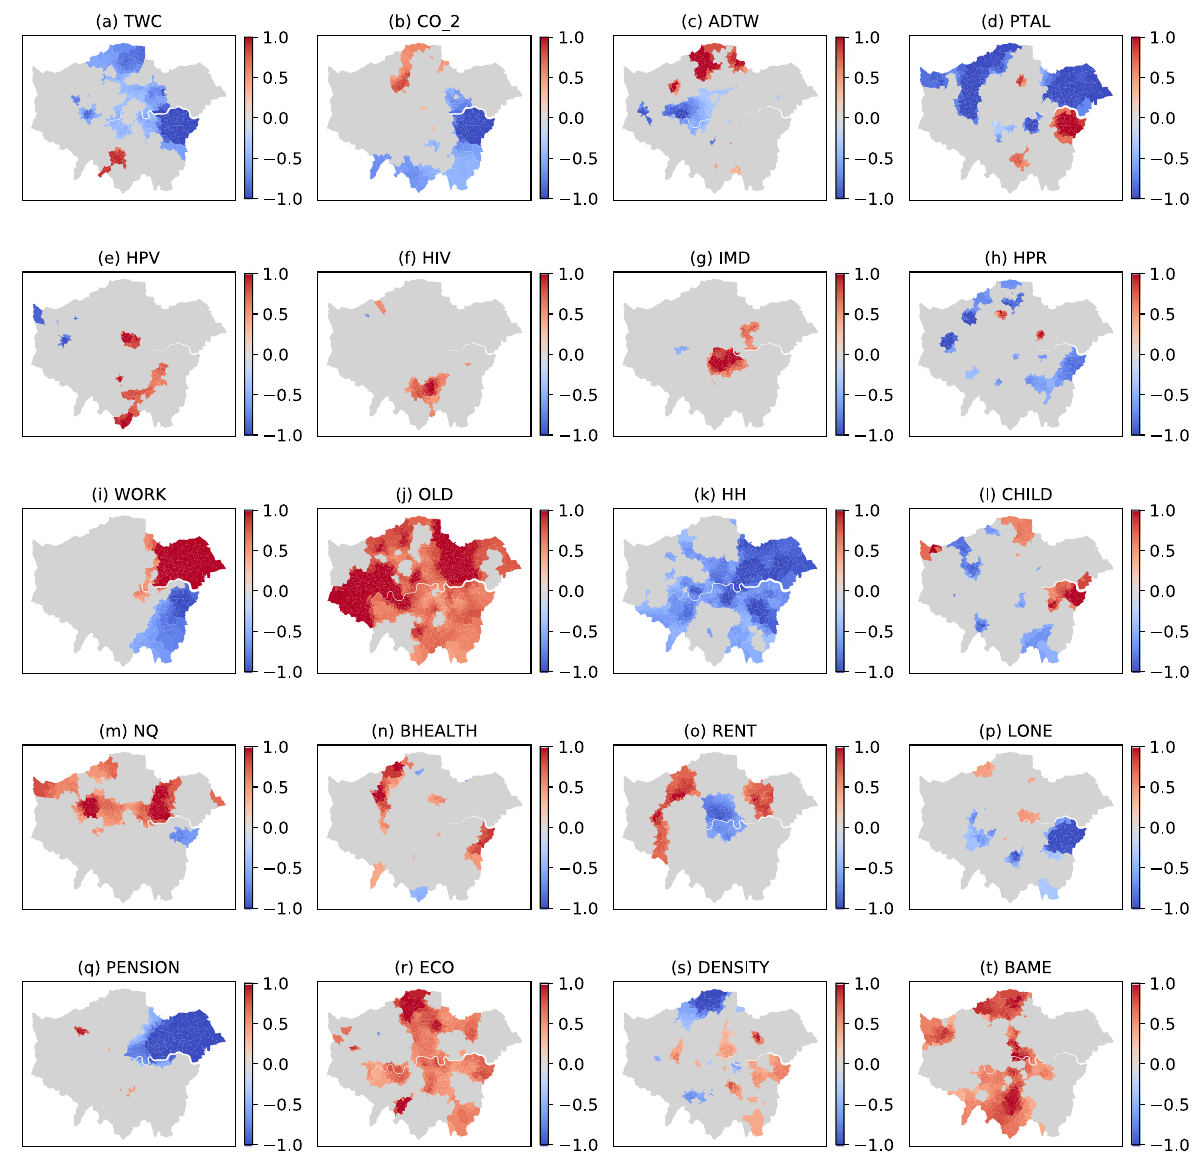
Fig. 6 Results for the parameter estimates of the MGWR